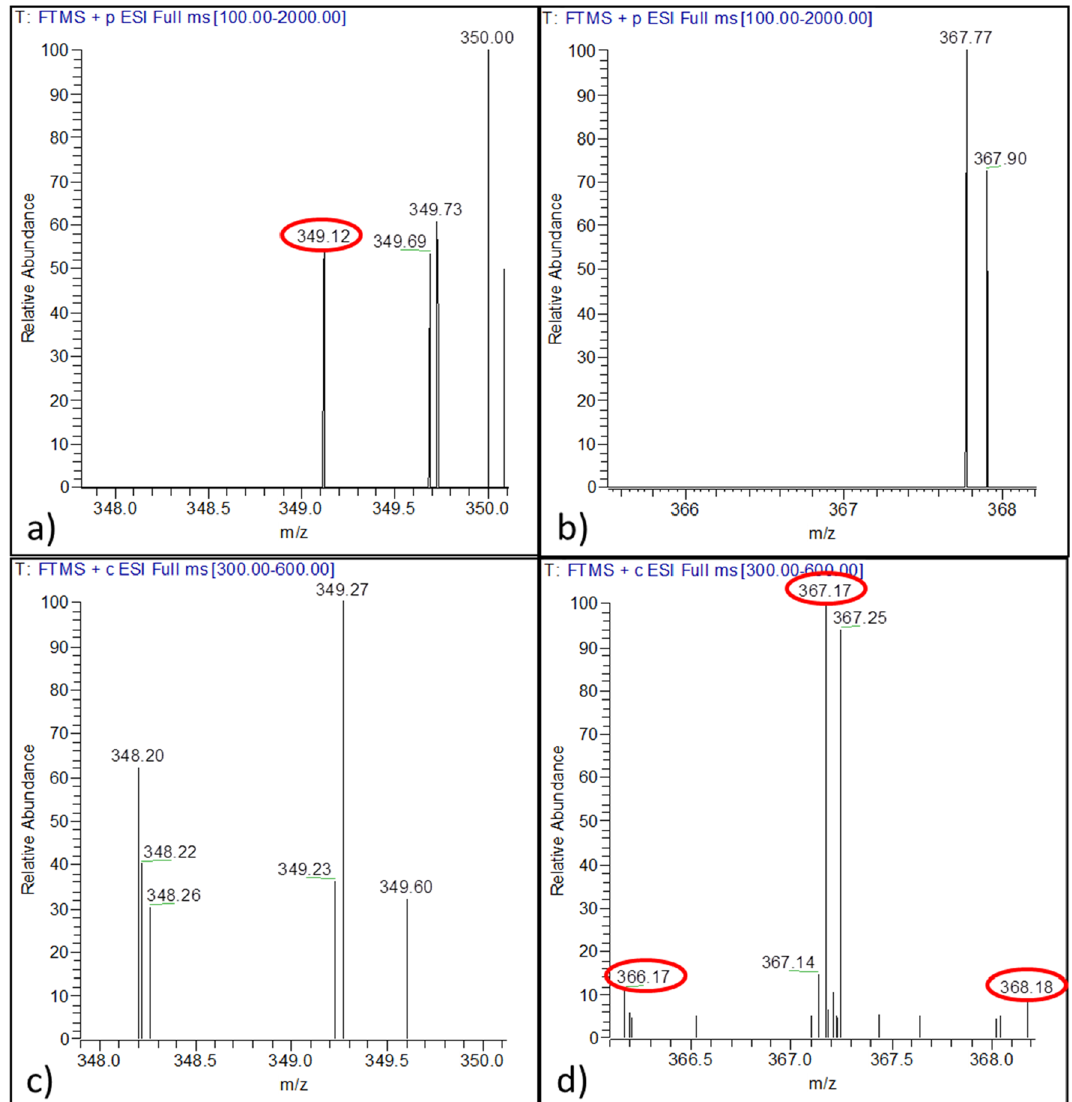
Figure 3. Confirmation of camptothecin biosynthesis in A. burnsii using d-[U- 13 C]-glucose. ( a ) Mass spectrum of the crude extract of camptothecin shows that non labelled camptothecin m/z of 349.12 was visualized only in d-glucose fed samples and ( b ) m/z corresponding to labelled camptothecin was not present in them. ( c ) Non labelled camptothecin m/z of 349.12 was not visualized in d-[U- 13 C]-glucose fed cultures ( d ) an m/z of 367.17 corresponding to 18 carbons in camptothecin being labelled was seen.